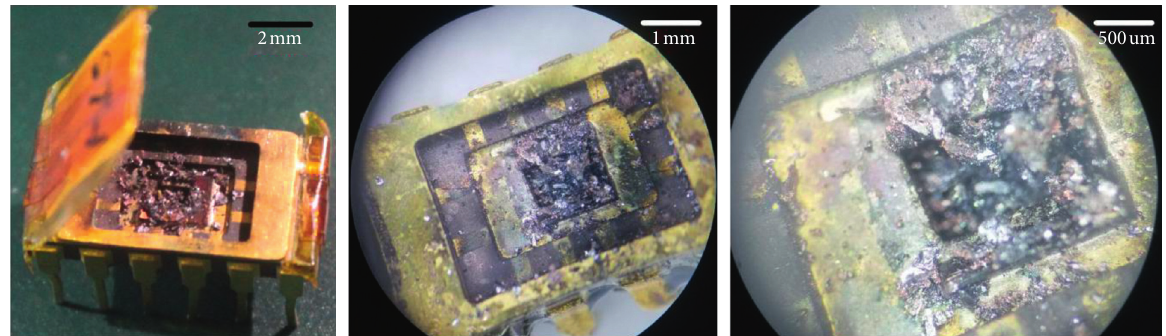
Figure 10: Appearance of the cracked